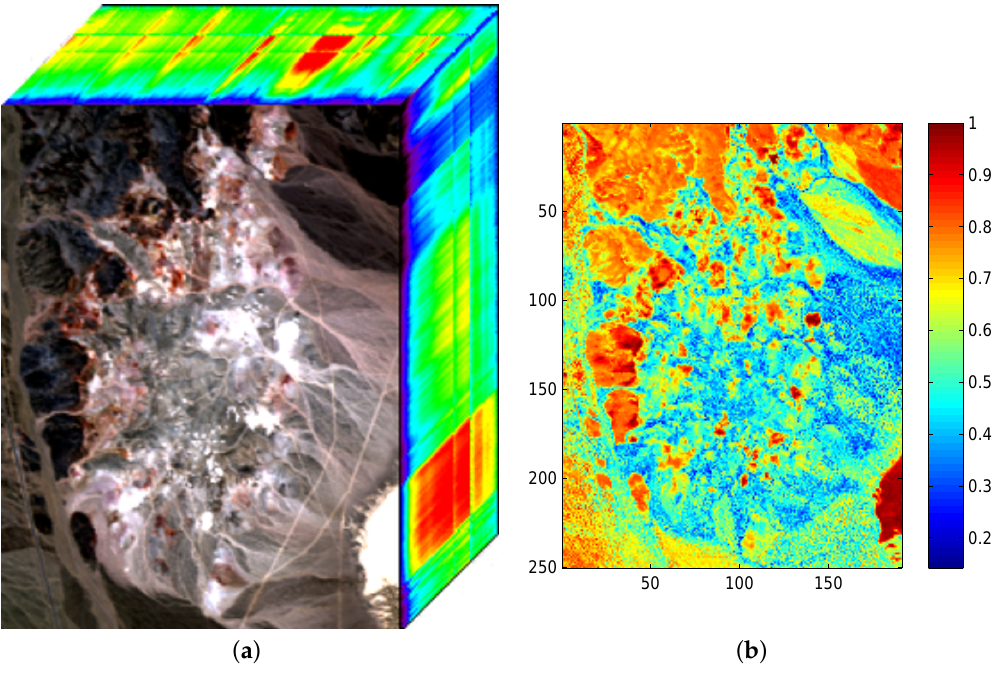
Figure 1. ( a ) Airborne visible/infrared imaging spectrometer (AVIRIS) hyperspectral data of the Cuprite mining district in Nevada, USA; ( b ) Estimated sparseness map from the obtained